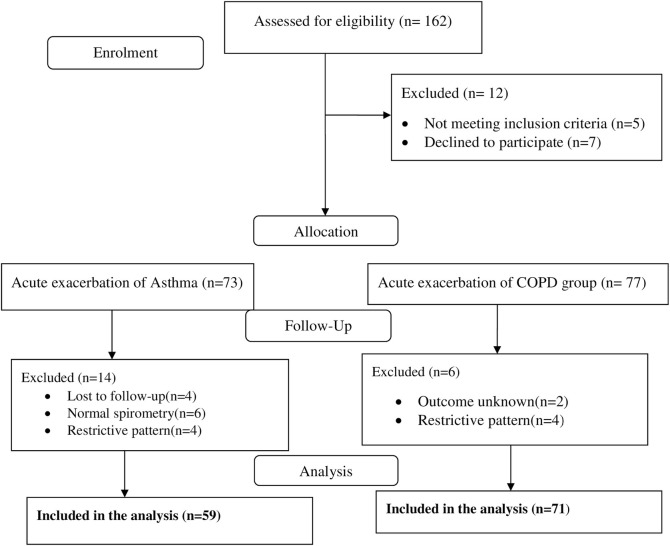
Sample recruitment diagram of study participants at JMC from April 20-September 20, 2019.